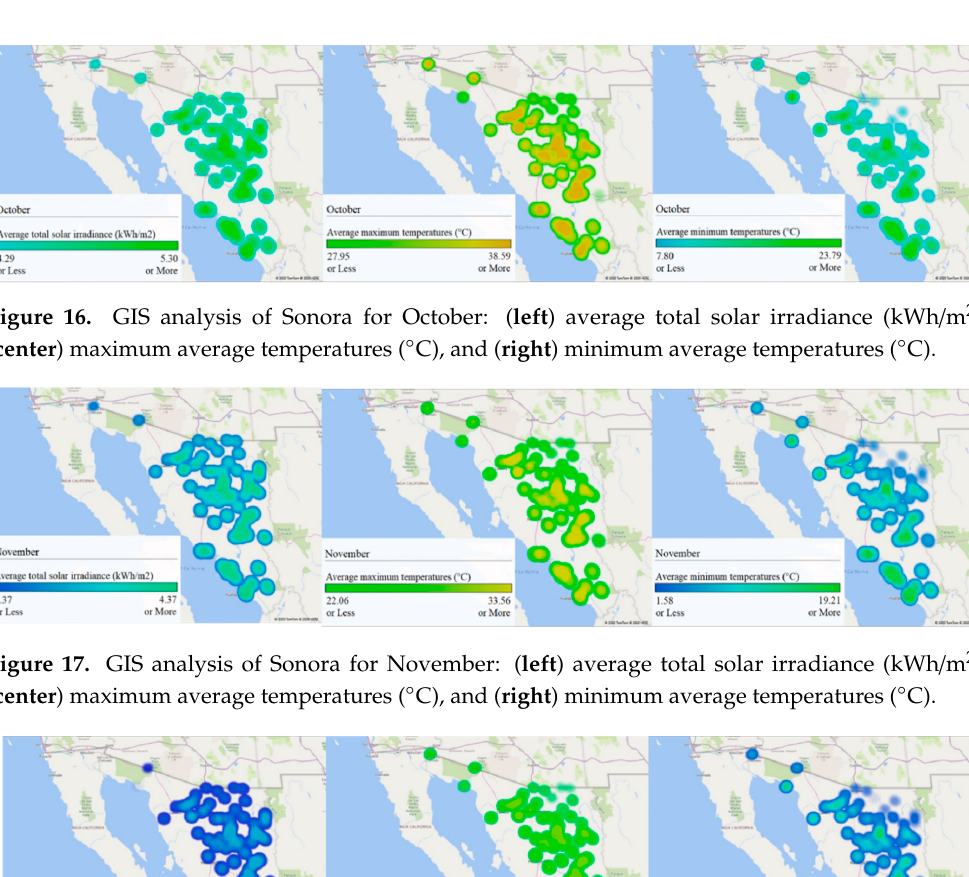
Figure 15. GIS analysis of Sonora for September: ( left ) average total solar irradiance (kWh/m 2 ),